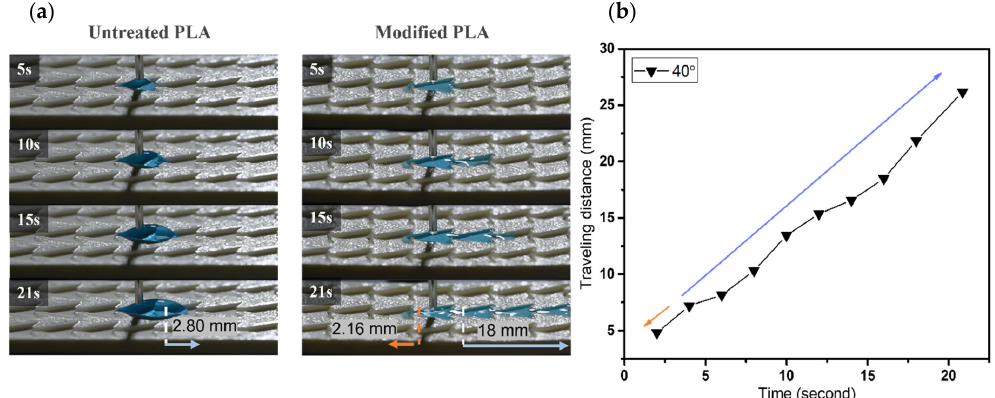
Figure 12. ( a ) The dynamic wetting behavior of water droplets in the 3D-printed dart-shaped pattern with β angle of 40 ° ; ( b ) Plot of traveling distance versus time with the directions of droplet movement wetting of modified pattern. The orange arrow denotes the opposite side, and the blue one denotes the predominant side.